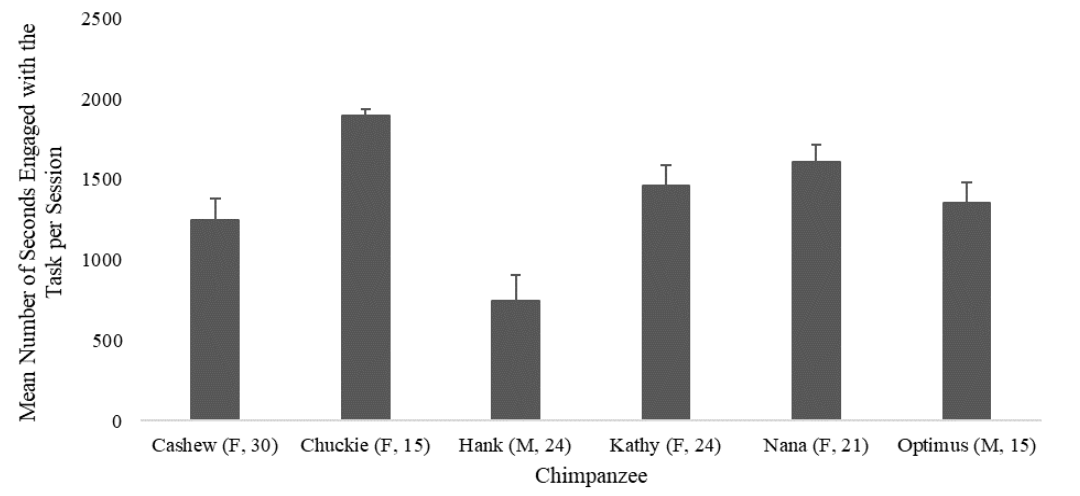
Mean Length of Time That Each Chimpanzee Engaged with the Task Within a Session Across all 10 Sessions Error Bars Show the Standard Error of the Mean.